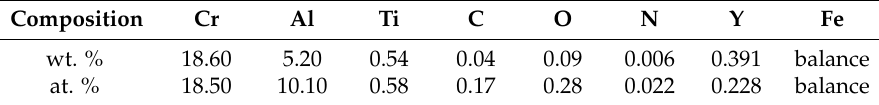
Table 1. Chemical composition of PM 2000, as determined by X-ray Fluorescence.